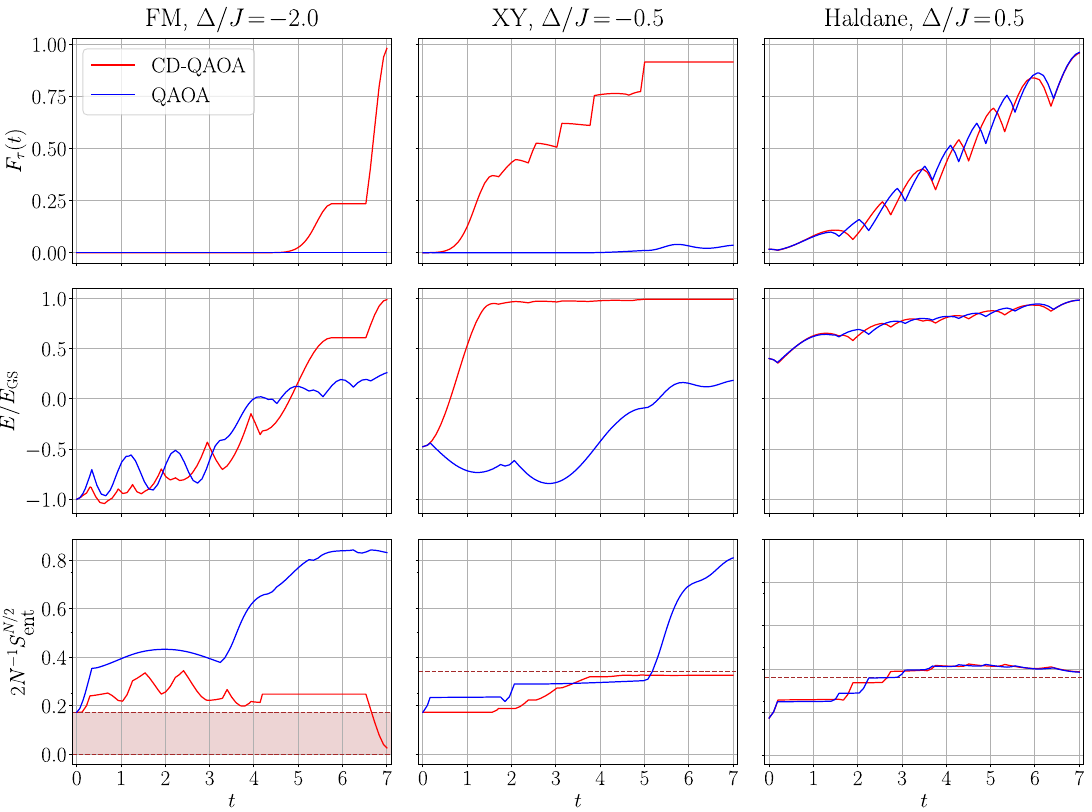
FIG. 20. Anisotropic Heisenberg spin-1 chain: time evolution generated by the protocol given by CD-QAOA (blue line) and conventional QAOA (red line) for the three target states, corresponding to the ferromagnetic ( Δ =J ¼ − 2 . 0 ), XY ( Δ =J ¼ − 0 . 5 ), and Haldane ( Δ =J ¼ 0 . 5 ) target states, respectively. Three quantities are shown: many-body fidelity (first row), energy ratio (second row), and the entanglement entropy density of the half chain (third row). The horizontal dashed line in the entanglement entropy curve shows the value in the target state, while the shaded area for the FM state denotes that in the span of the doubly degenerate ground-state manifold. The protocols correspond to the duration T ¼ 7 in Fig. 3. The related CD-QAOA protocol sequences are given in Table V(b) [ferromagnetic ( Δ =J ¼ − 2 . 0 )], Table V(d) [ XY ( Δ =J ¼ − 0 . 5 )], and Table V(c) [Haldane ( Δ =J ¼ 0 . 5 )]. The simulation parameters are the same as in Fig.